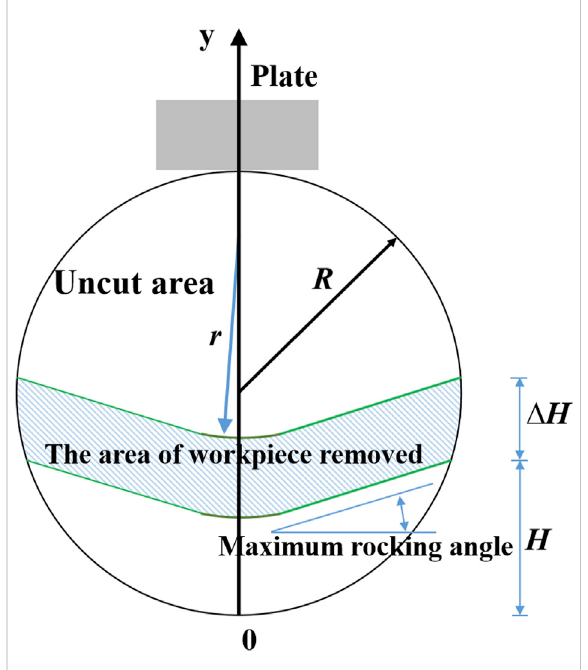
FIGURE 7 Wire saw area chart for a certain period of the circular wafer.